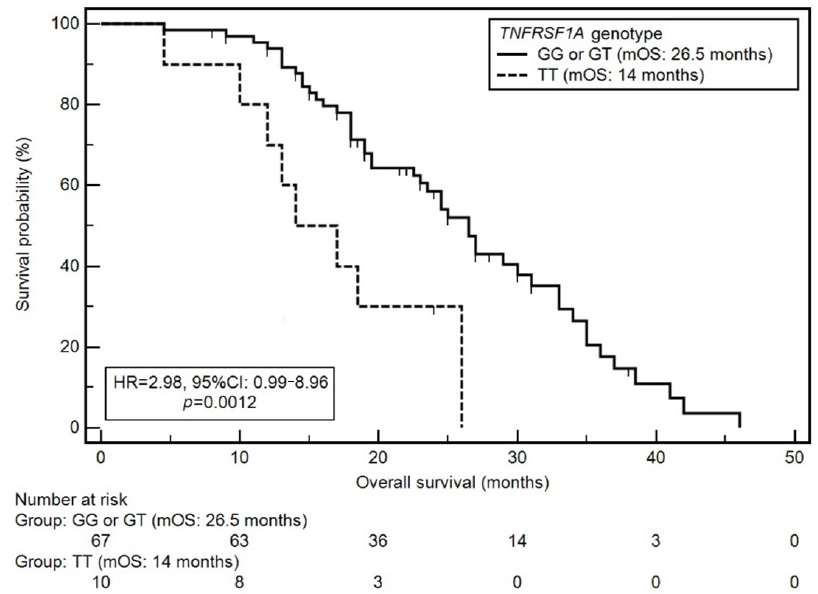
Figure 2. Kaplan–Meier curves showing the probability of overall survival depending on the presence of a specific genotype of the TNFRSF1A gene.